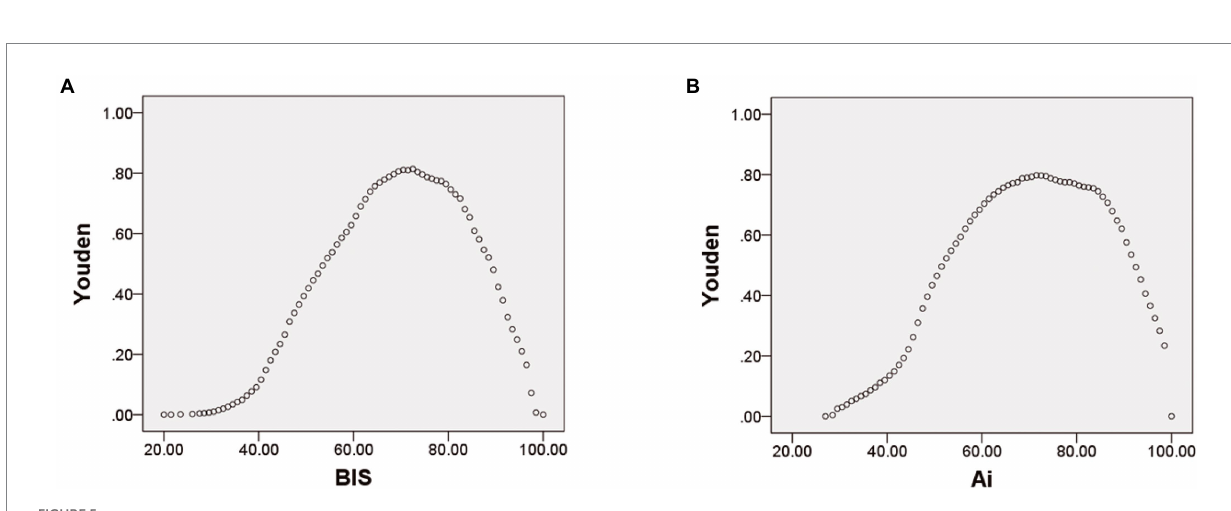
FIGURE 5 BIS with the Youden index (A) and Ai with the Youden index (B)